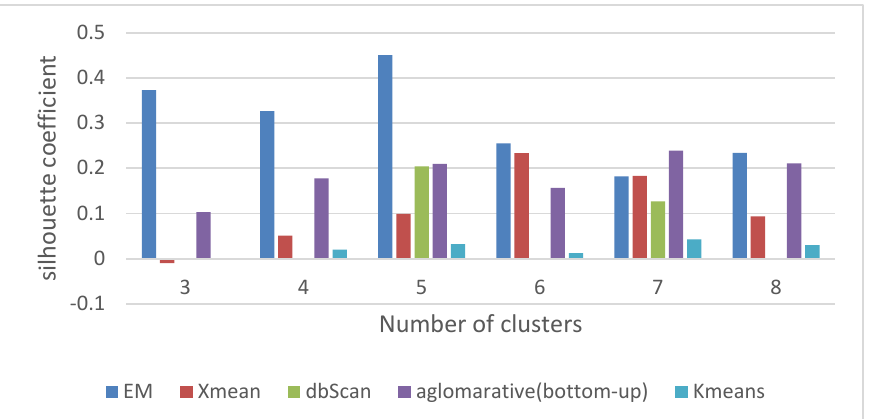
23 of 47 Figure 9. A schematic of the data production tree with two fault and non-fault categories by the use of Quest algorithm. 3.3. Clustering Analysis and Fault Cause Identification In this section, we examine the results obtained from the clustering performed on the performance support system data. In clustering, the data is generally divided into traffic and signaling data categories. The results of each type and their analysis are given in the following. First, the traffic clusters were checked, and then the signaling clusters were